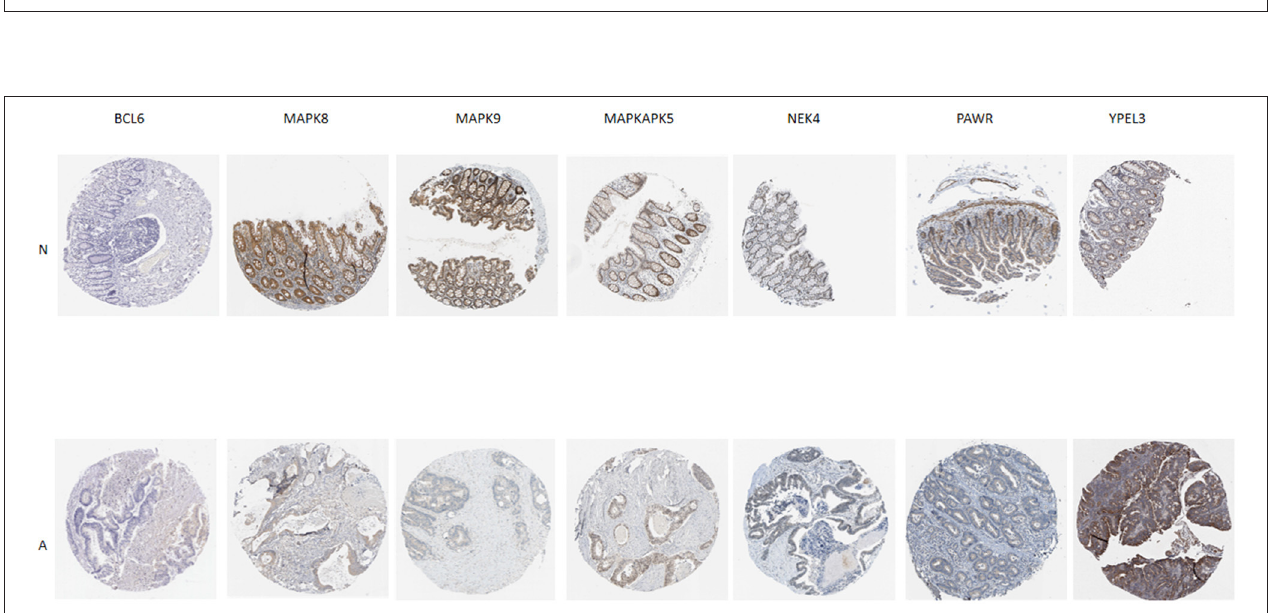
FIGURE 7 | Verification of SRG expressions in normal and tumor tissue by immunohistochemistry staining based on The Human Protein Atlas (THPA) database. N represent normal tissue, A represent CRC tissue.